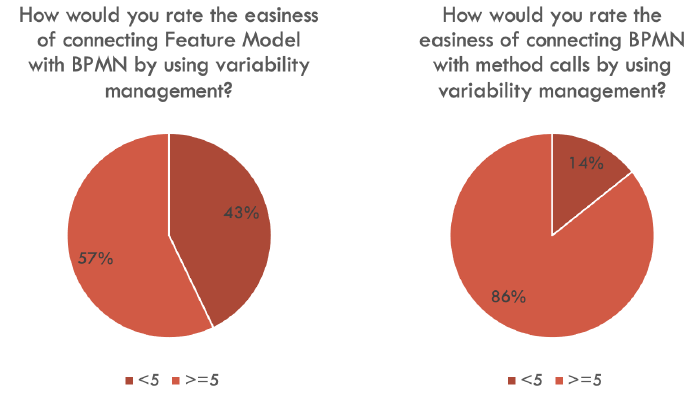
Figure 9. Questions about transitions between models and the responses .